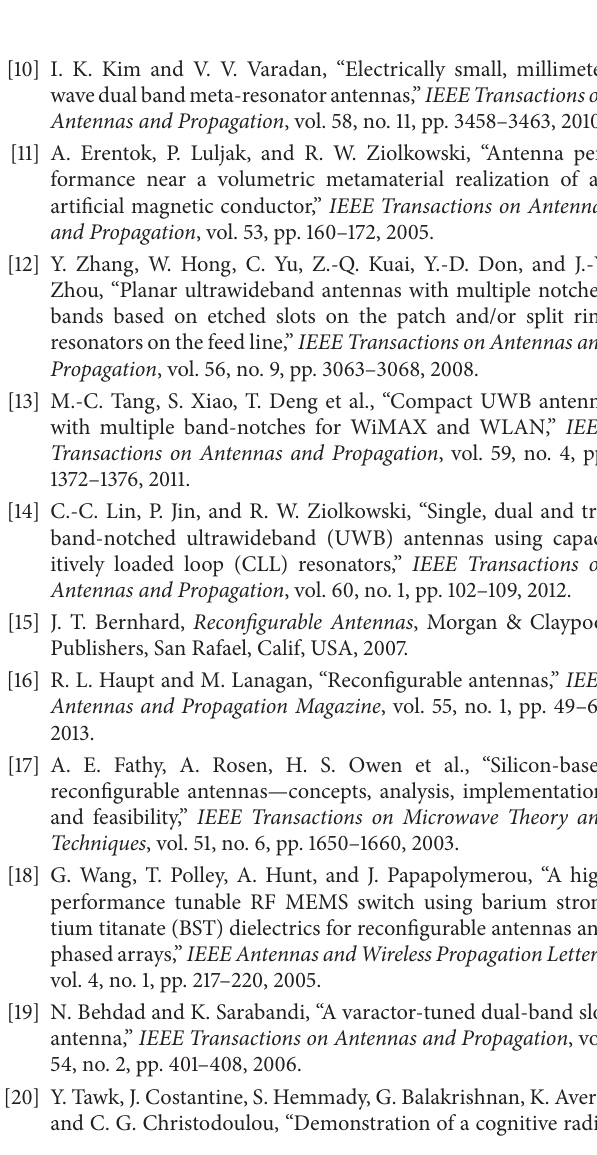
Figure 17: Measured 3D radiation patterns of the prototype two-NFRP element reconfigurable antenna at 𝑓 𝑅 = 1.180 GHz: (a) State 1 and (b) State